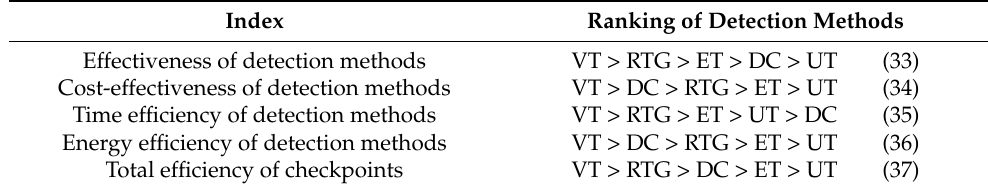
Table 3. Rankings of detection methods in relation to analysed variables. Index Ranking of Detection